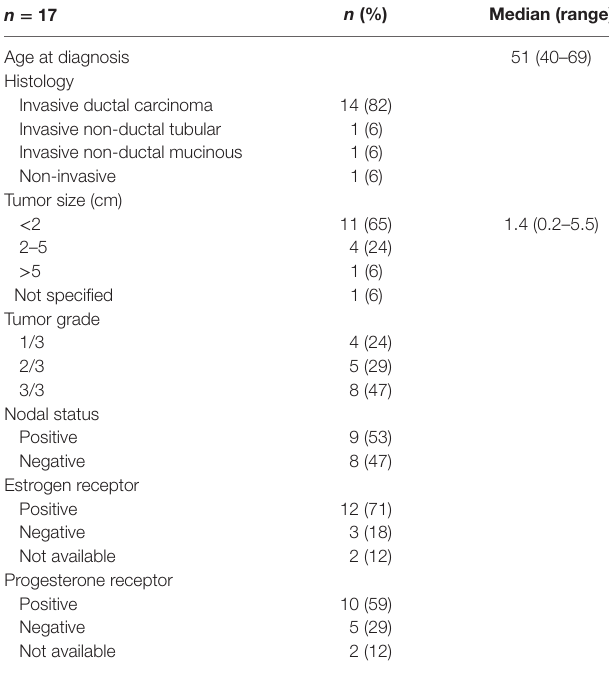
TaBle 1 | Characteristics of breast cancer